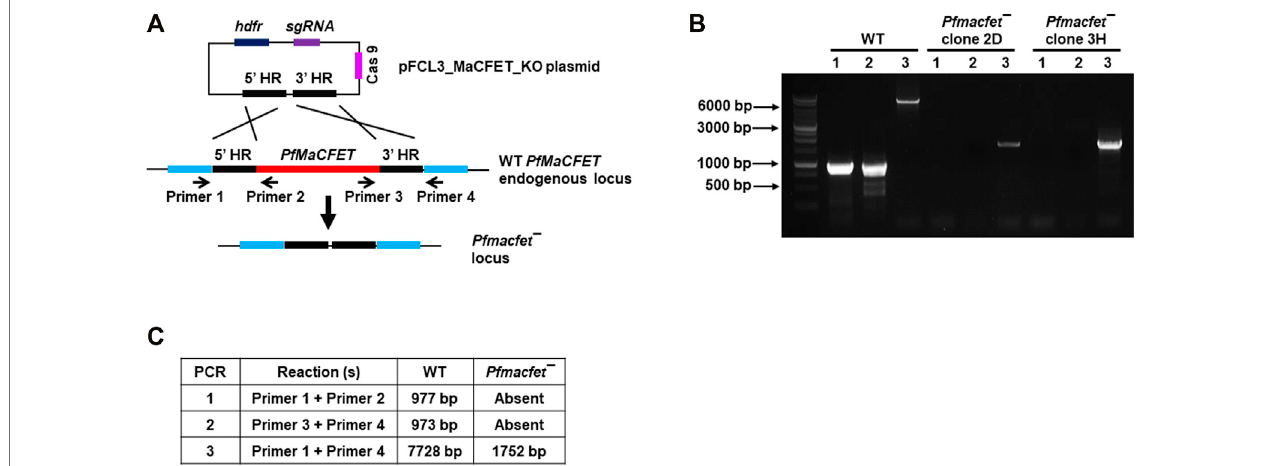
FIGURE 3 | Generation of Pfmacfet (cid:1) parasites. (A) For generation of Pfmacfet (cid:1) parasites a similar strategy as described in Figure 1 was used. pFCL3_PfMaCFET_KO plasmids had homology regions from 5 ′ (5 ′ HR) and 3 ′ (3 ′ HR) of the PfMaCFET locus, a single guide RNA seq (sgRNA) and human dihydrofolate reductase (hDHFR). (B,C) PfMaCFET deletion con fi rmation via diagnostic PCR. The oligonucleotides were designed from outside the 5 ′ HR and 3 ′ HR and the PfMaCFET locus and positions are indicated by arrows in (A) . The expected amplicon sizes for different set of PCR primer combinations are indicated in (B,C) .